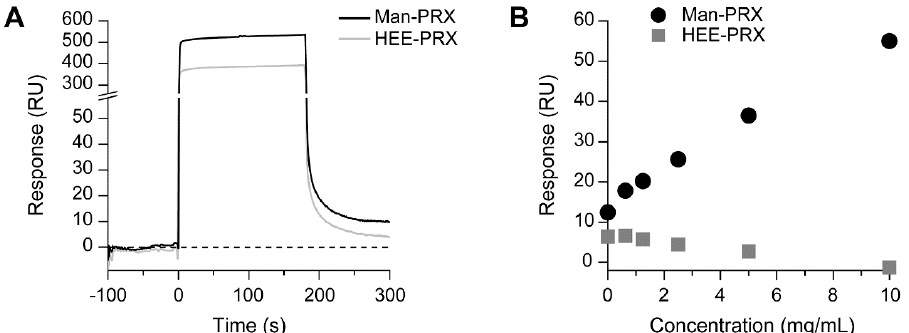
Figure 4. ( A ) SPR sensor grams of Man-PRX (5 mg/mL) and HEE-PRX (5 mg/mL) on the mouse MMR- immobilized sensor chip surfaces. ( B ) Relationship between PRX concentration and the SPR response. The circles and squares in the plot indicate Man-PRX and HEE-PRX,